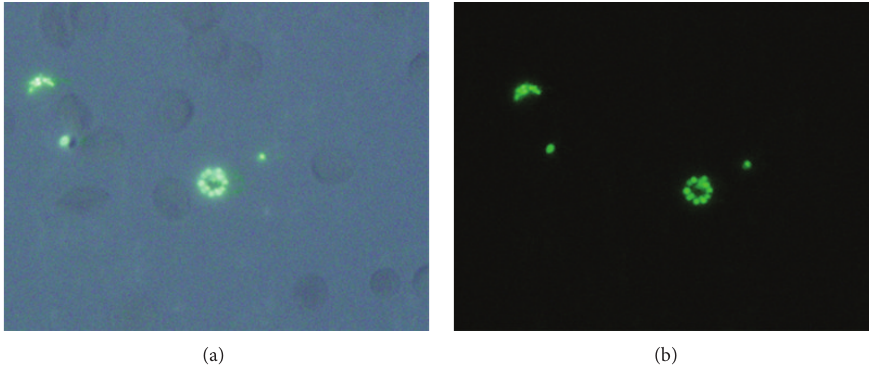
Figure 1: P. falciparum infected RBCs were stained with SYBR Green I and were then examined using a microscope with (a) DAPI and (b) fluorescence filter. Photographs indicated fluorescent images of parasites at schizont (center) and merozoite stages (outer).